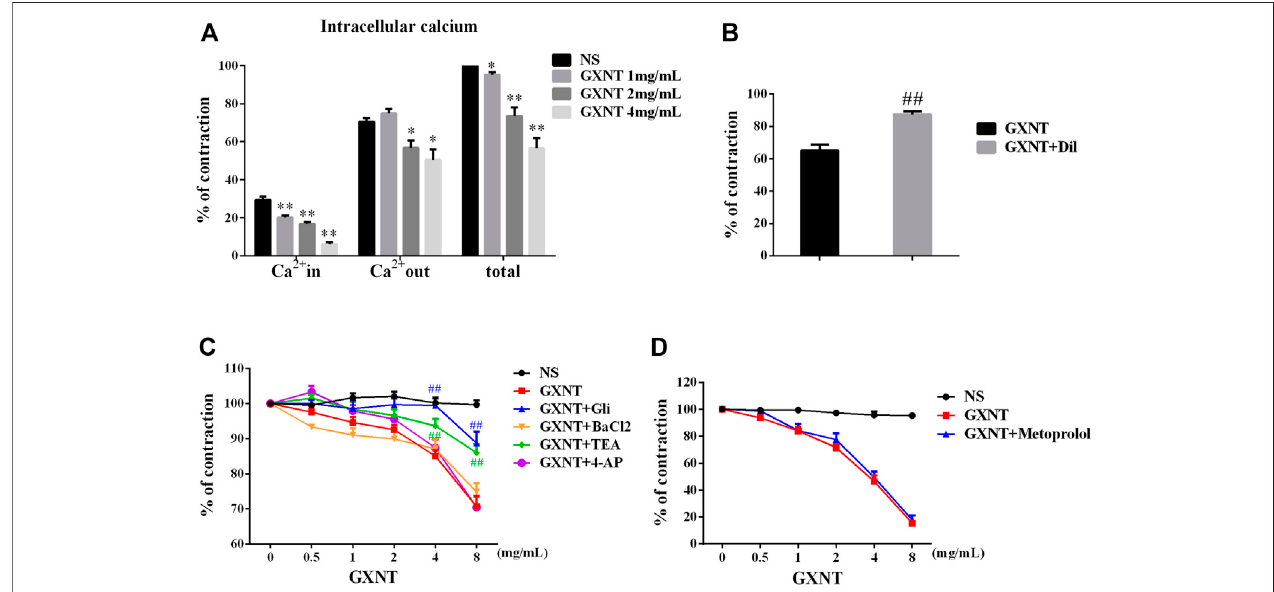
FIGURE2| EffectsofGXNTonionchannelsand β receptorsinendothelium-denudedaorticrings. (A) Changesinintracellularandextracellularcalciuminendothelium- denuded aortic rings. (B) In fl uences of calcium in fl ux on the vasodilatory effect of GXNT. Diltiazem hydrochloride (Dil) (10 − 5 M), a calcium in fl ux blocker, was given 30 min before10 – 6 mol/LPE,and4 mg/mlofGXNTwasadded,andthetensionwasrecordedandcompared. (C) Effectsofdifferentpotassiumchannelsonthevasodilationeffect ofGXNT. Ringswerepreincubatedwith the K Ca inhibitor tetraethylamine (TEA) at 10 − 3 M, K ATP inhibitorglibenclamide (GLI) at 10 − 5 M, the K v inhibitor4-aminopyridine (4-AP)at10 − 3 M,andtheK IR inhibitorbariumchloride(BaCl 2 )at10 − 3 Mfor30 minfollowedbytheadditionof10 − 6 mol/LofPEandGXNTatincreasingconcentrationsof0.5, 1, 2, 4,and 8 mg/ml. The differences in tension before and after addition ofthe inhibitors were compared. (D) The effect of β receptor blockade on the vasodilatory effect of GXNT was tested. Metoprolol (10 − 6 M) was applied as pretreatment 30 min before 10 − 6 mol/L PE and GXNT were added in turn. In the NS group, PE and GXNT were not given, but normal saline was used instead ( *p < 0.05, **p < 0.01 compared with the NS group, ## p < 0.01 compared with the GXNT group). The vasoconstrictive tension before the addition of the drug was taken as 100% of the normal control group, and the tension after the addition of the drug was compared with it and is reported as a percentage. Results are presented as the mean ± S.D. of the data obtained in three independent experiments with six duplicate